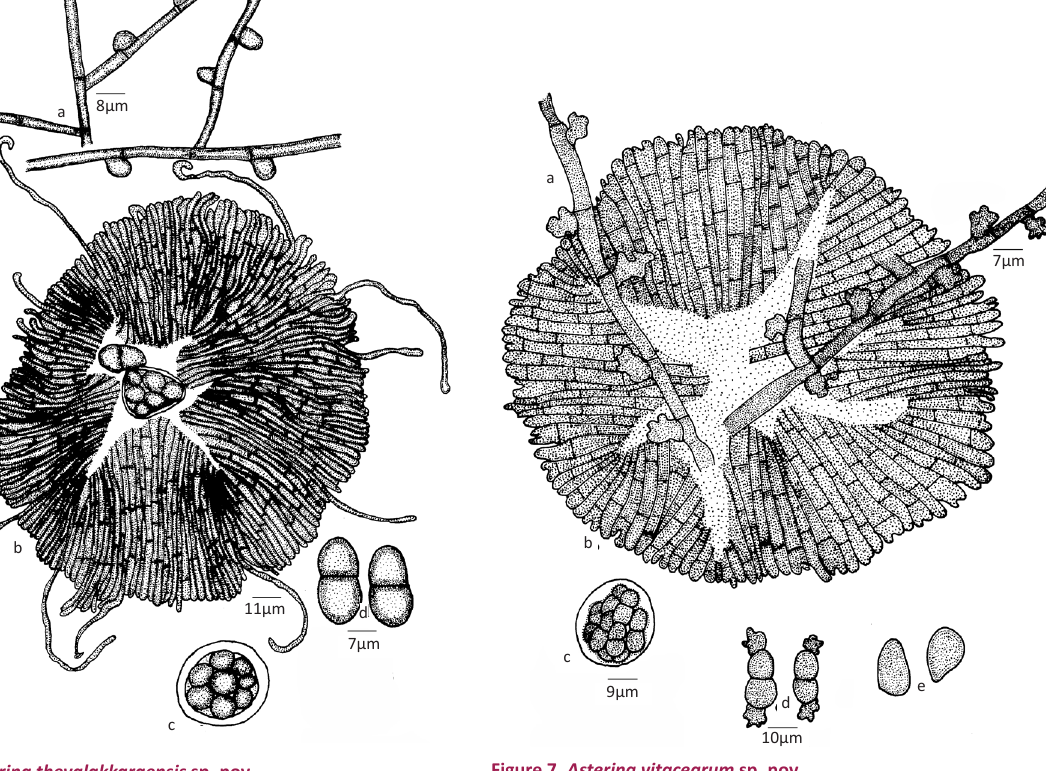
Figure 6. Asterina thevalakkaraensis sp. nov. a - Appressoriate mycelium; b - Thyriothecium; c - Ascus; d - Ascospores